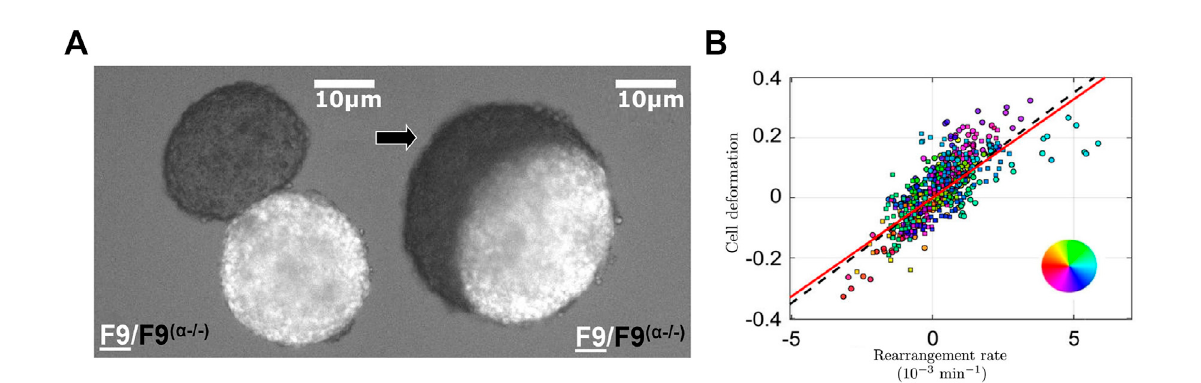
FIGURE 4 Effect of adhesion regulation in vitro cellular systems (A) Merging of two cellular aggregates made from F9 cells (white) and F9 ( α − / − ) cells in which α -cateninhasbeenknockedout(black),3 h(left)and29 h(right)aftercontact.DuetothereductionofadhesionstrengthinF9( α − / − )cells,the black aggregate (lower surface tension) deforms around the more cohesive white aggregate (higher surface tension), in agreement with the differential adhesion hypothesis. Adapted with permission from [75]. (B) Cell deformation as a function of the rearrangement rate in a 2D monolayer of MDCK cells migrating around an obstacle. The correlation between deformation and rearrangement rate is in agreement with a viscoelastic liquid Maxwell model. Adapted with permission from